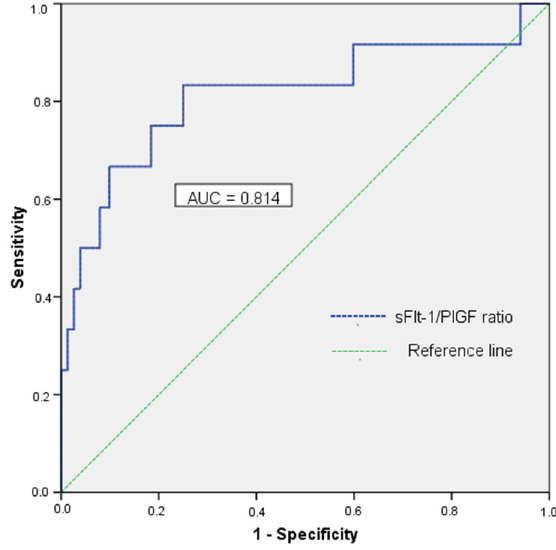
Figure 2. Receiver operating characteristic curve for the sFlt1/PlGF ratio. The ROC curve showing the sFlt1/PIGF ratio as the best predictor for HDP, with an AUC of 0.814.